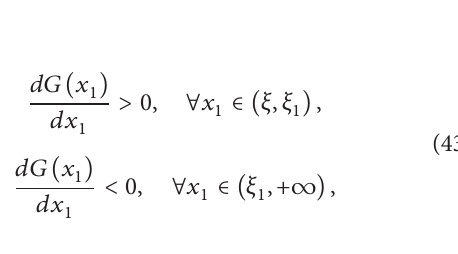
Figure 1: (a), (b), (c), and (d) Dynamical behavior of system (4). Here, we take three sets of initial values (1, 1.2), (0.6, 0.8), and (0.2, 1).